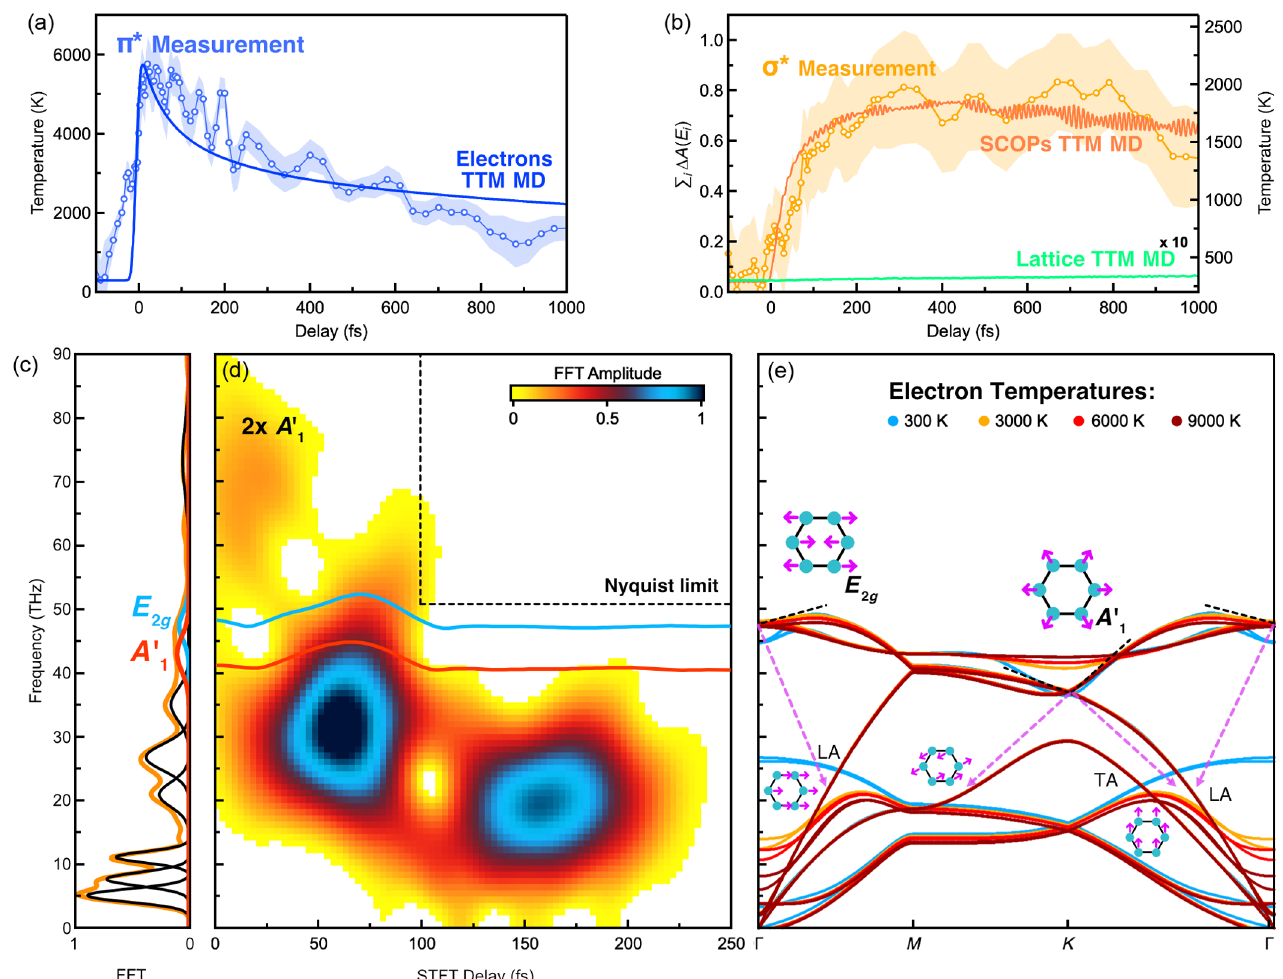
FIG. 4. Phonon dynamics retrieved from attosecond XANES. Panels (a) and (b) show results from the TTM MD simulation (solid lines) together with experimental data from Fig. 2. The evolution of the electronic temperature is shown in (a) while (b) shows the SCOPs and lattice subsystems. Panel (c) shows results from a Fourier analysis of the experimental σ (cid:2) data [shown in (b)]. A multipeak fit are shown in red and blues, respectively. (d) Short-time Fourier transform reveals the predominant modes; positions of the A 0 1 and E 2 g (STFT) of the σ (cid:2) data (b) over a time range of 250 fs, visualizing coherent phonon contributions. A comparison with the calculated phonon dispersion (e), for different electronic temperatures (see SM [11]), allows us to identify the phonon modes, their main branches (dashed lines), and their dispersion into longitudinal (LA) and transvers acoustic (TA) modes (dashed arrows). Striking are the high- frequency oscillations at twice the phonon frequency of A 0 1 , the simultaneous and fast rise of the coherent Raman active E 2 mode, g concomitantly with the non-Raman-active A 0 1 mode, and the rapid decay into coherent low-frequency phonons and their temporal